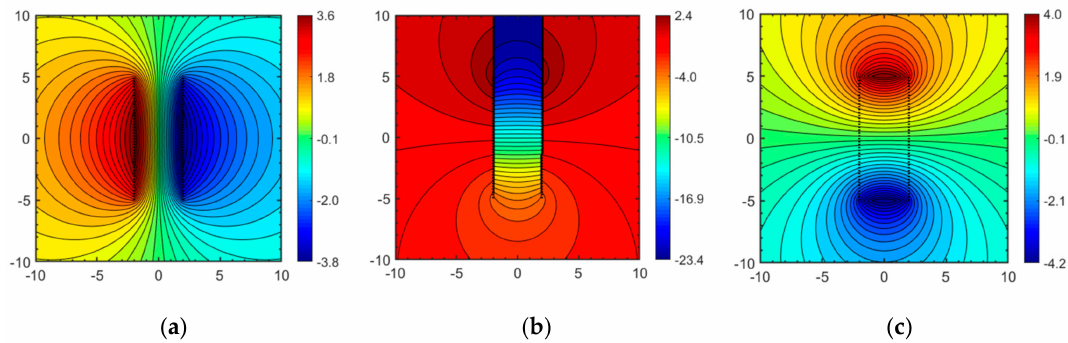
Figure 16. Areal dipole. ( a ) Potential lines ( Φ ). ( b ) Streamlines and stream function ( Ψ ) solved by MATLAB, and ( c ) Streamlines and stream function ( Ψ ) solved using the procedure explained in Appendix A (rainbow colors). Strength of the superposed line dipole is ( υ ) = 100 m 4 · s − 1 and z c =